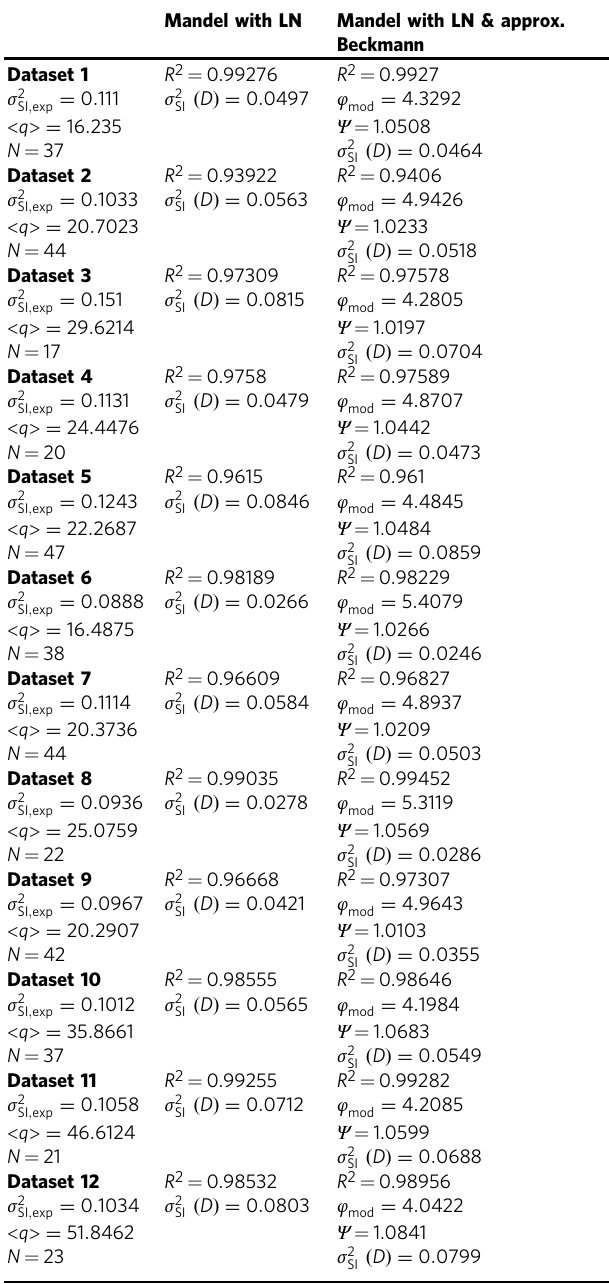
Table 1 Goodness-of- fi t and fi tting parameters for photon- count datasets. Mandel with LN Mandel with LN & approx.